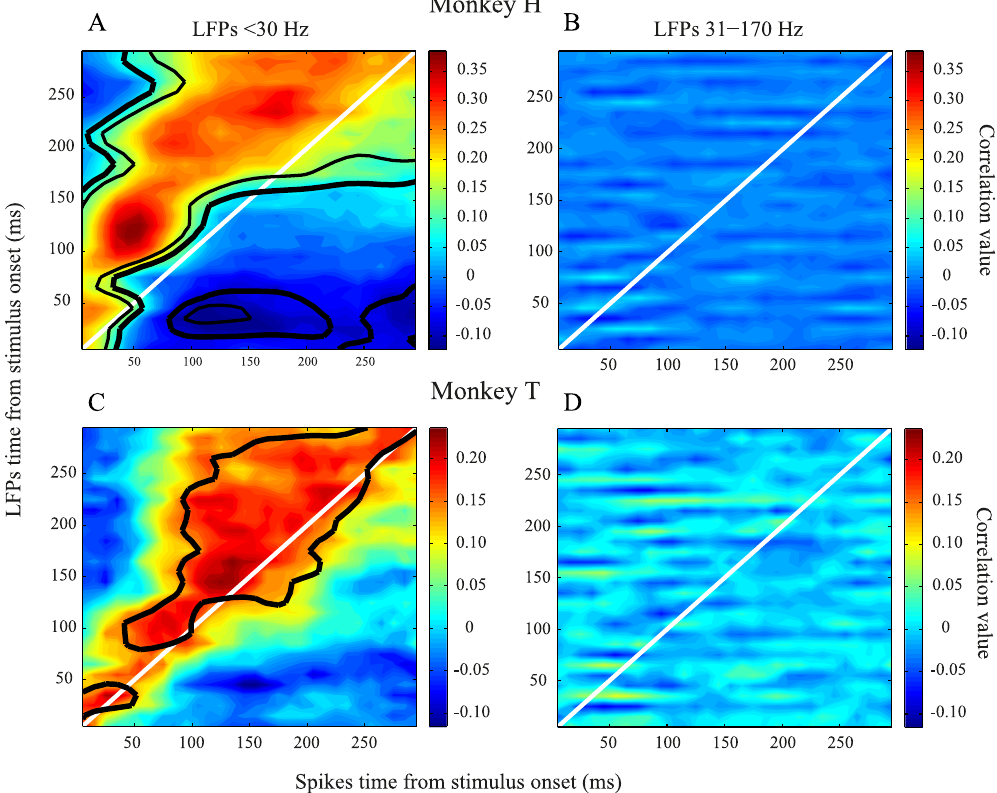
Figure 5. Correlation maps based on LFPs of different frequency bands. ( A , C ) LFPs of frequencies lower than 30 Hz were used to create the correlation maps. ( B , D ) High frequency LFPs with frequencies higher than 30 Hz were considered here. Top and bottom panels correspond to monkeys H and T, respectively. Maps follow the same convention of color coding as in Fig.